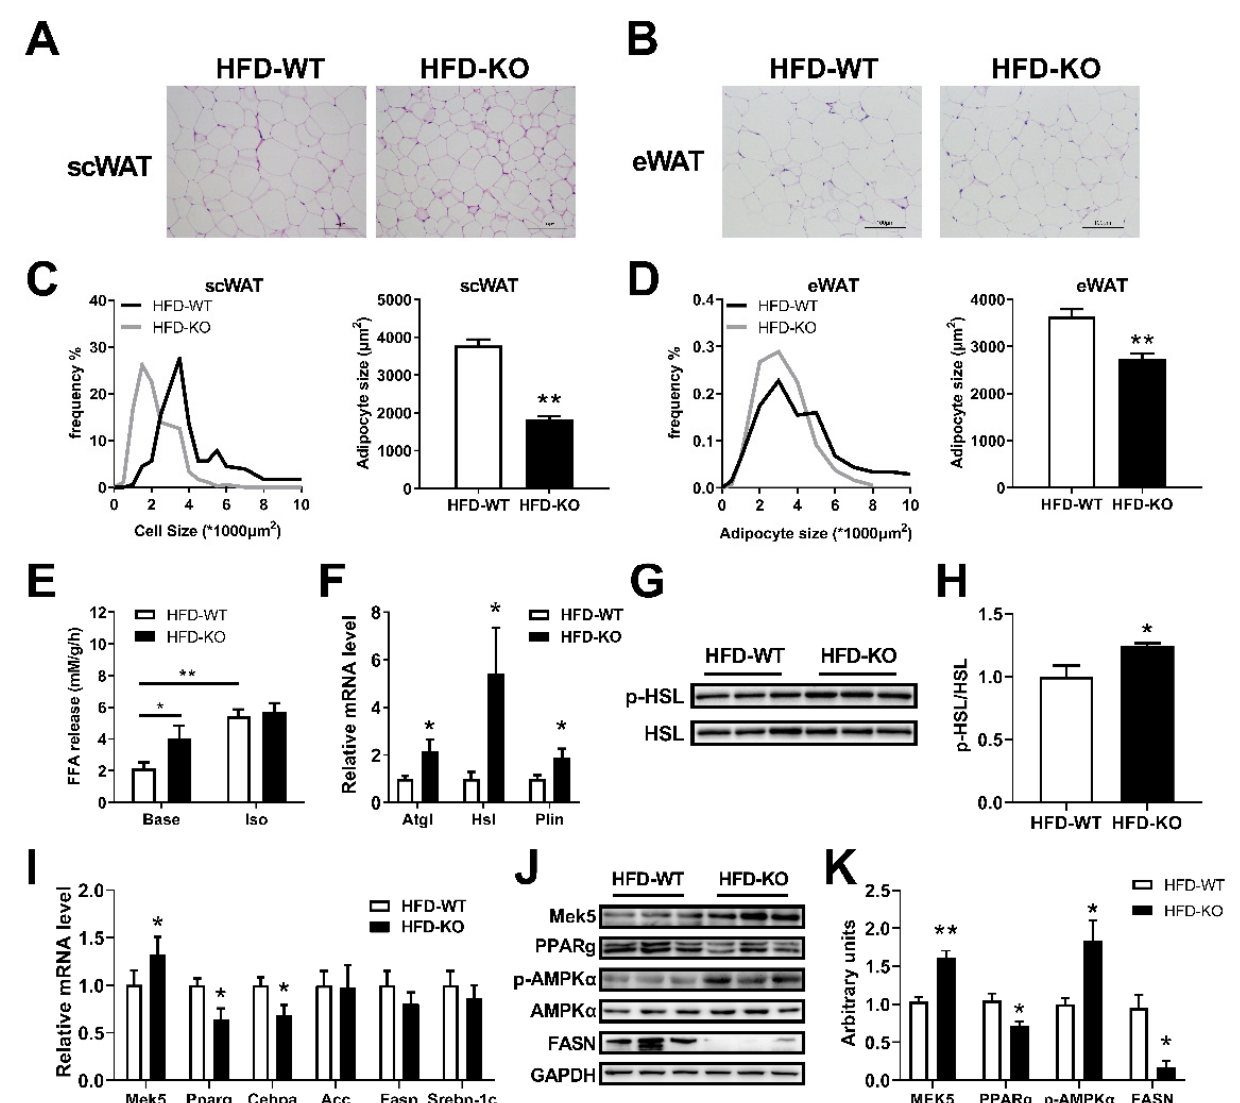
Figure 6. miR-143KO promoted lipolysis and inhibited the adipogenesis of WAT in HFD-fed mice. ( A , B ) Morphologic analysis of adipocytes in scWAT and eWAT. Scale bars: 100 µ m. ( C , D ) The adipocyte sizes and the frequencies of the cell size were calculated. Three sections from different individuals (n = 3) per group were randomly selected. ( E ) Fatty acid release capacity of scWAT in WT and KO mice fed HFD for 1 week (n = 4). ( F – H ) The lipolysis-related genes mRNA (n = 8) and protein expression levels in the scWAT. ( I – K ) The adipogenic-related genes mRNA (n = 8) and protein expression levels in the scWAT. Data are presented as the mean ± SEM. * p < 0.05 vs. controls; ** p < 0.01 vs. controls, as determined by a two-tailed unpaired Student’s t